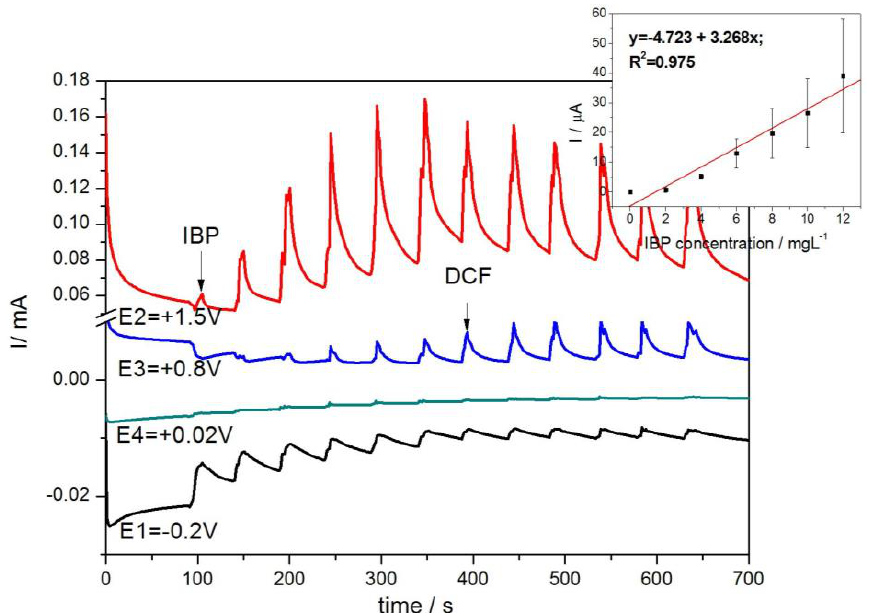
Figure 8. Multiple-pulsed amperograms recorded at HKUST-CNF electrode in 0.1 M Na 2 SO 4 supporting electrolyte, consecutively and continuously adding each of 2 mg·L −1 IBP and respective, DCF, recorded at E1 = −0.2 V/SCE, E2 = +1.5 V/SCE, E3 = +0.8 V/SCE, E4 = +0.02 V /SCE. Inset: Calibration plots of the currents recorded at E = +1.5 V vs. SCE versus IBP concentrations.